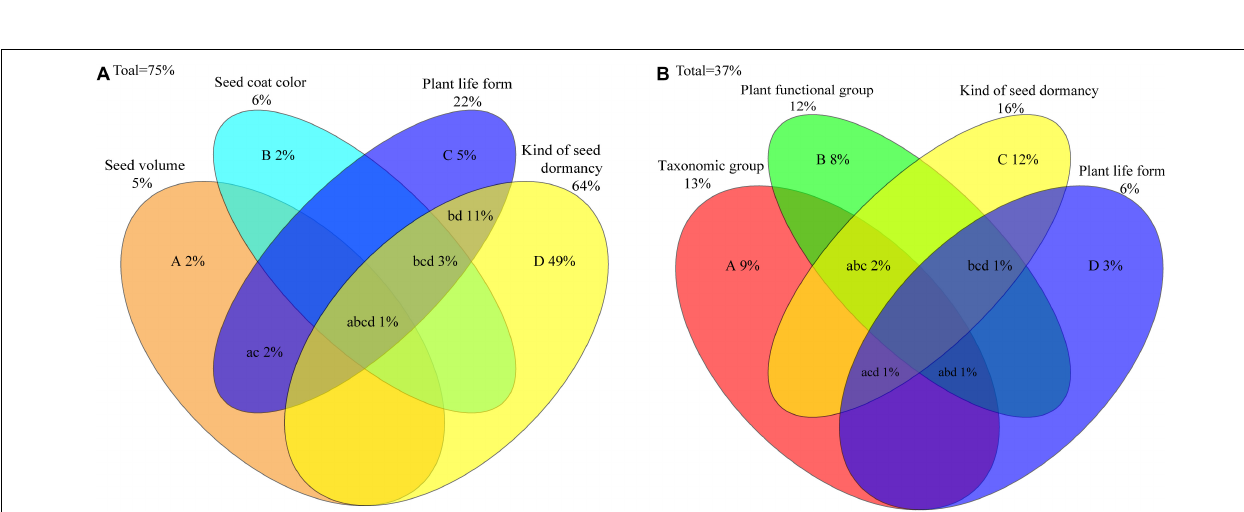
Frontiers in Ecology and Evolution |